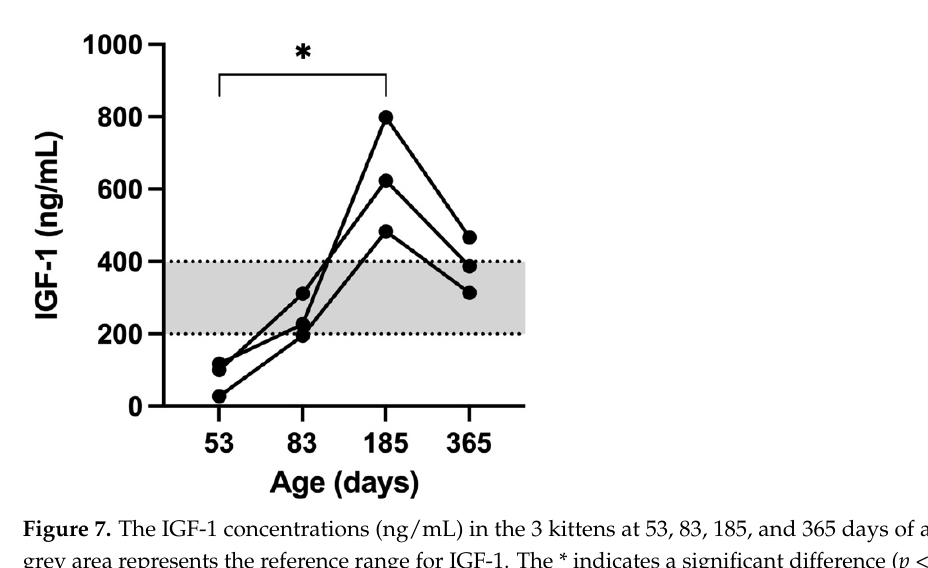
Figure 6. The differences in BW among the groups at days 0 ( a ), 53 ( b ), 83 ( c ), 185 ( d ), and 365 ( e ). The * indicates a significant difference in the multiple comparisons Dunn’s test, p < 0.05.